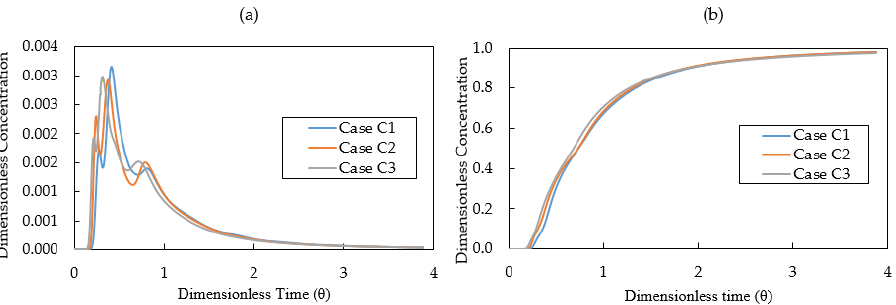
Figure 16. ( a ) E-curve and ( b ) F-curve for different heat flux at top surface (Case C1: 7.5 kW/m 2 , Case C2: 15 kW/m 2 , Case C3: 30 kW/m 2 ).